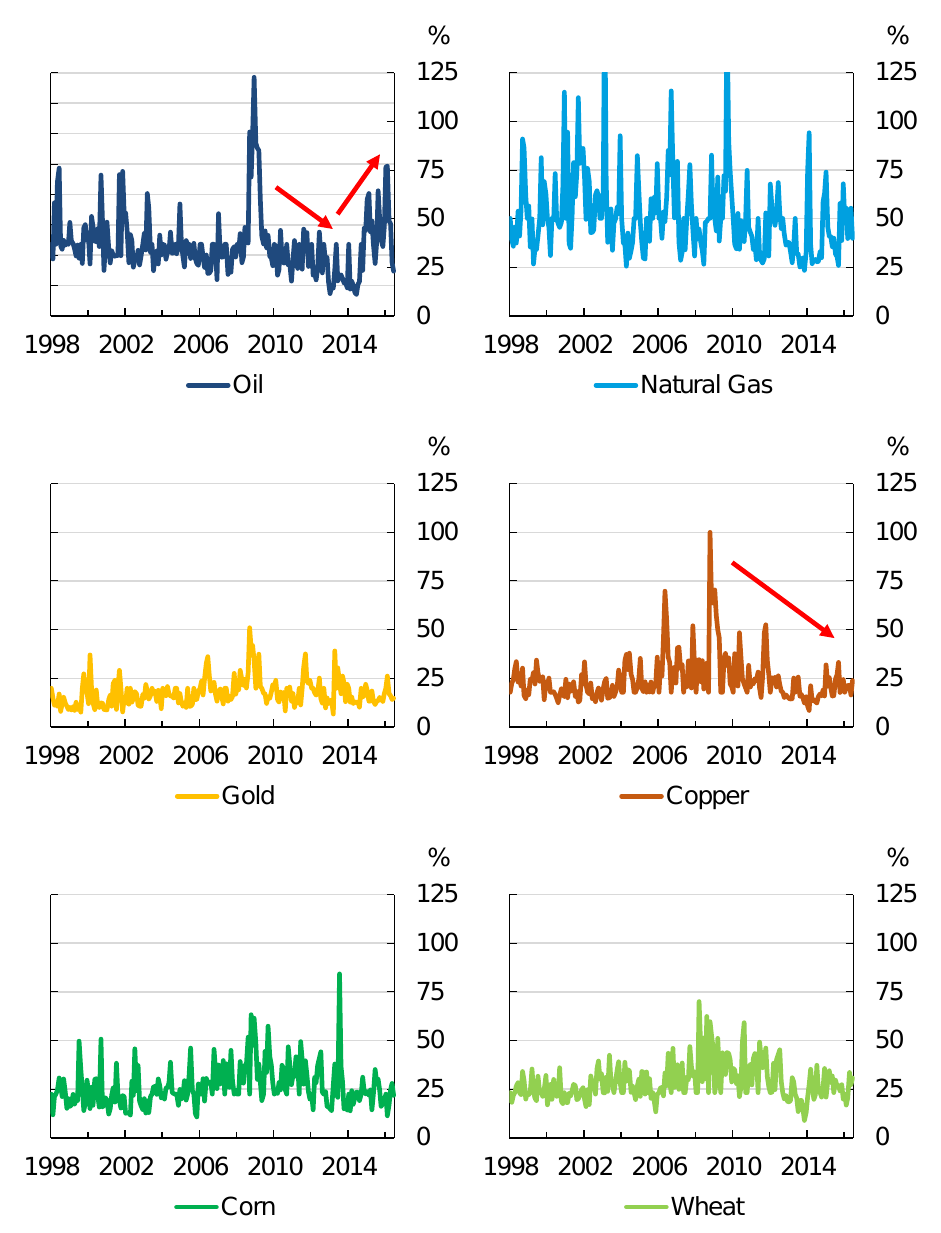
Figure 1. Realized Volatility for Select